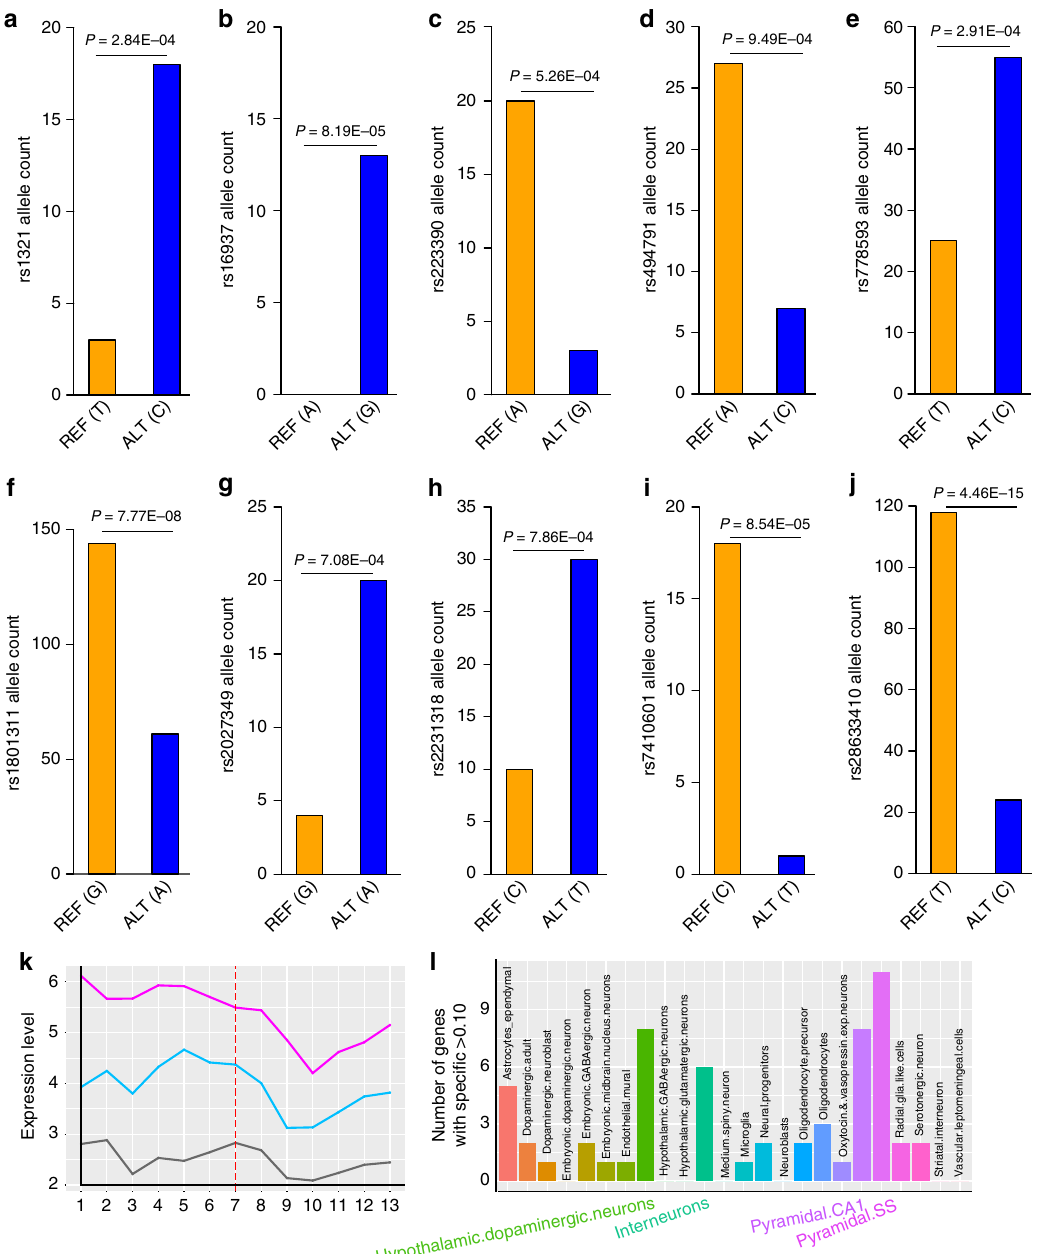
Fig. 8 Allele-speci fi c expression analysis results and expression pattern of target genes. a – j Ten transcription factor (TF) binding – disrupting single- nucleotide polymorphisms (SNPs) showed signi fi cant (Binomial P < 0.001) allele-speci fi c expression (allelic imbalance) in human brain tissues from the GTEx. For each SNP, the counts of the reference allele and the alternative allele are shown. Of note, reporter gene assays also support that different alleles at rs1801311 and rs16937 conferred signi fi cant differences in luciferase activity, further supporting the regulatory effect of rs1801311 and rs16937. k Expression pattern of target genes of the identi fi ed regulatory SNPs across different developmental stages. The target genes of the identi fi ed regulatory SNPs showed a signi fi cant higher expression level compared with background genes ( P < 1.0 × 10 − 7 for gene set in Supplementary Table 5, and P < 5.0 × 10 − 7 for gene set in Supplementary Data 4). In addition, we also found that the expression level of the target genes was higher in prenatal stage compared with postnatal stage ( P = 0.001 for gene set in Supplementary Table 5, and P = 0.008 for gene set in Supplementary Data 4). The gray line represents the expression level of the background genes, the pink line represents the expression level of target genes listed in Supplementary Table 5, and the light blue line represents the expression level of target genes listed in Supplementary Data 4. l Cell type-speci fi c expression analysis of the target genes of the identi fi ed regulatory SNPs. Target genes with a speci fi city score >0.1 were extracted and the number of targets genes with a speci fi city score >0.1 were plotted. Of note, the pyramidal cells have the most number of target genes, suggesting that the expression of target genes were enriched in pyramidal cells. Source data are provided as a Source Data fi